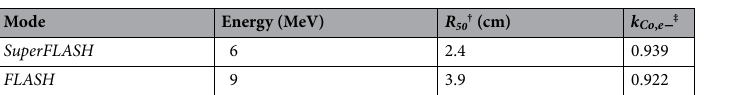
Table 1. Beam quality correction for the AMIC. † Interpolated from Fig. 9. ‡ Interpolated from PTW paperwork.